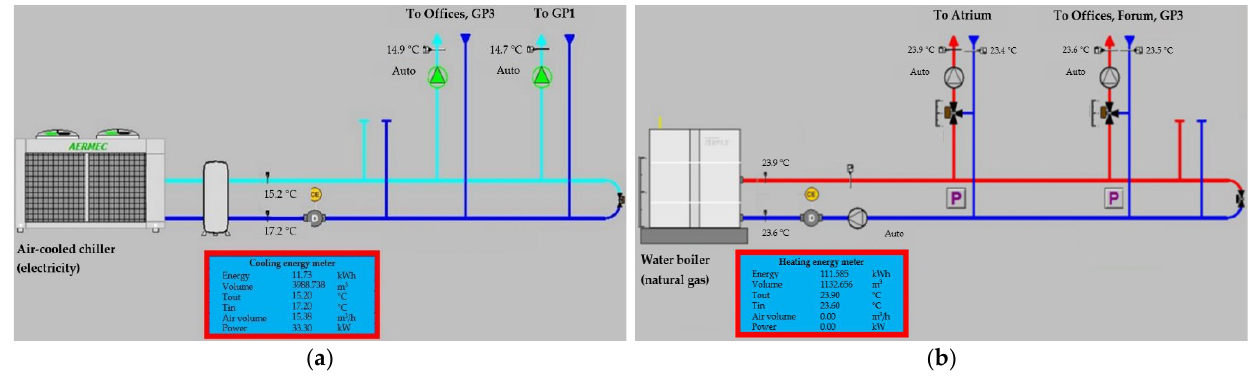
Figure 4. Reference building measurement locations used for the thermal comfort evaluation: ( a ) measurement locations on Floor +1; ( b ) satellite image with landscape from Google maps.